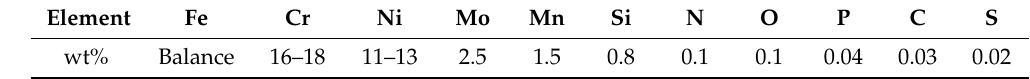
Figure 2. SEM image of the starting powders. Table 3. Chemical composition of 316L SS.